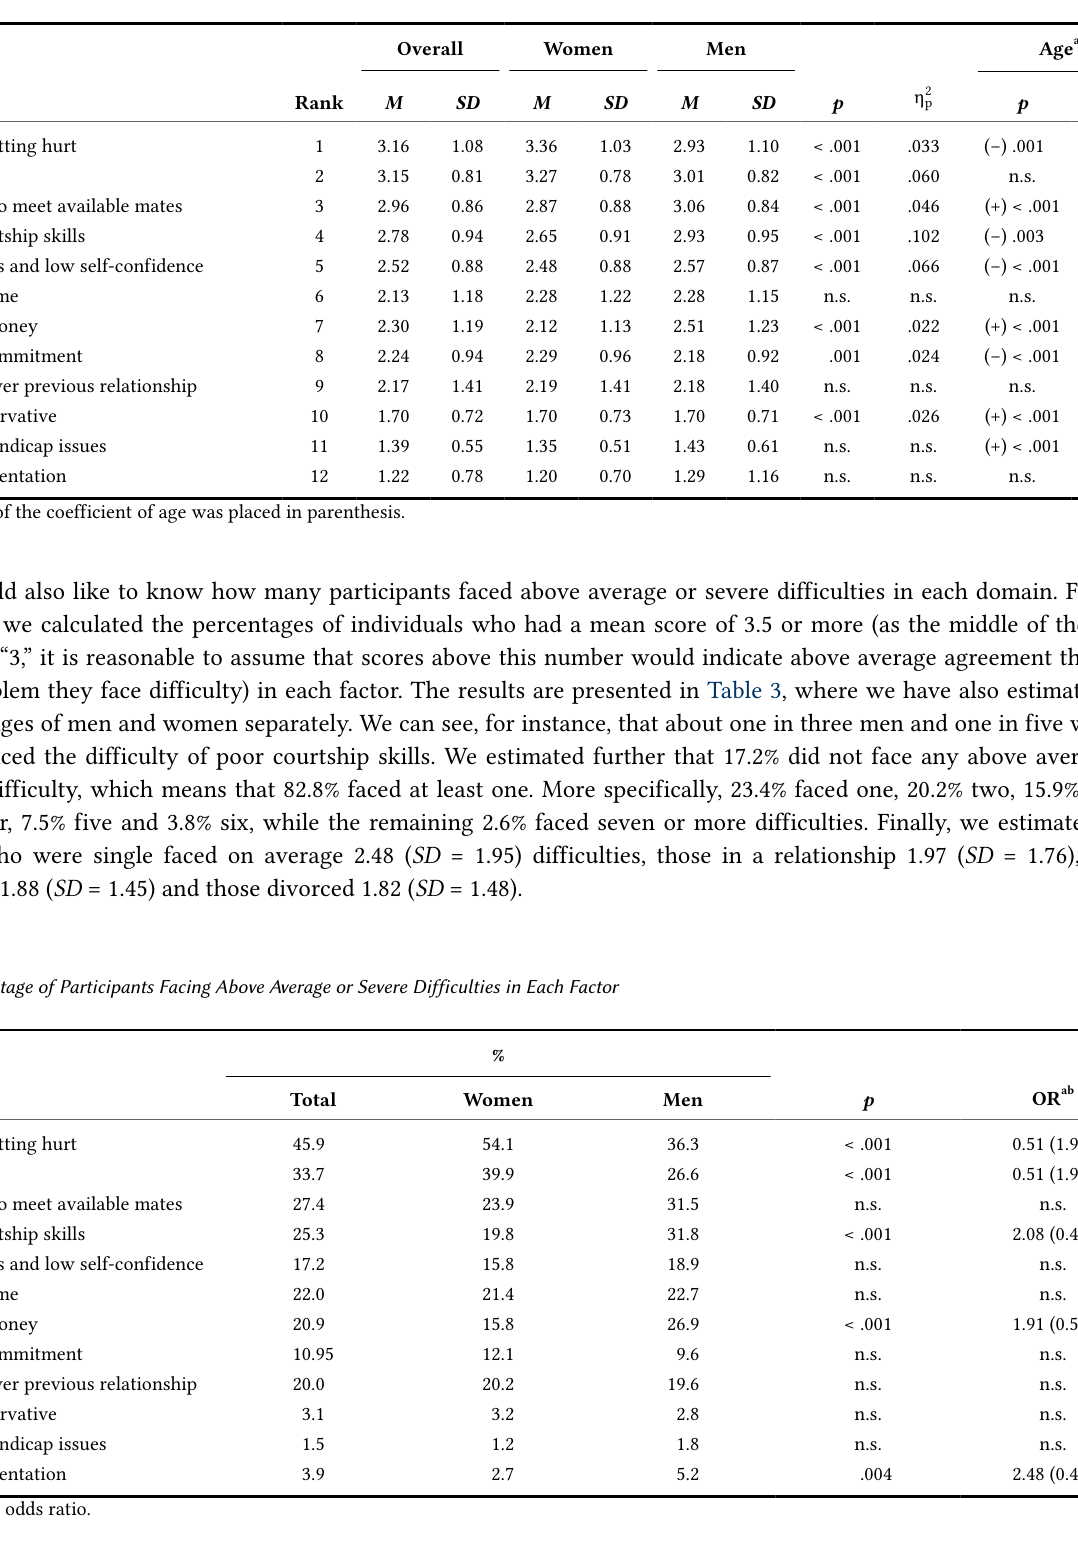
Significant Gender and Age Effects for the 12 Extracted Factors in Study 2